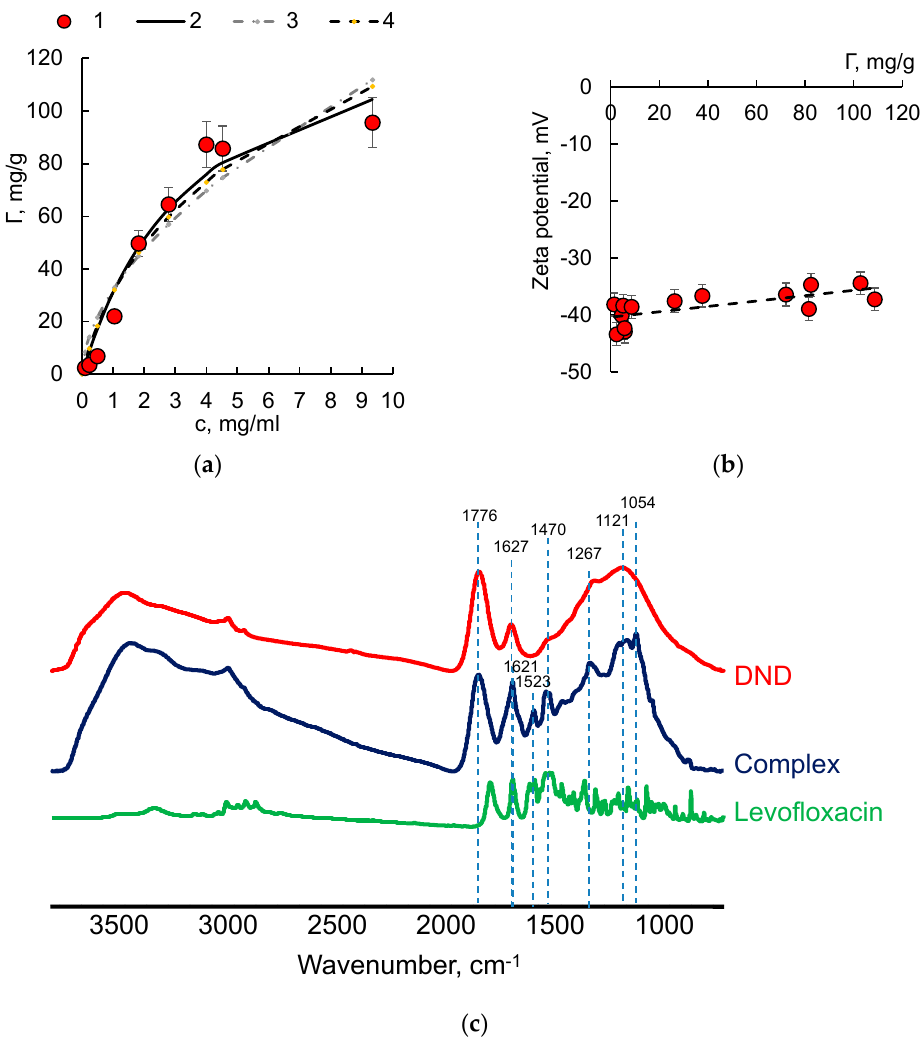
Figure 3. Characteristics of DND–levofloxacin complex. ( a ) The dependence of levofloxacin surface concentration on its equilibrium concentration in the aqueous phase (1) experimental data, (2) fitting with Langmuir equation, (3) fitting with Freundlich equation, (4) fitting with Dubinin–Radushkevich equation. ( b ) The dependence of zeta potential of DND–levofloxacin species in the aqueous suspension on levofloxacin surface concentration. ( c ) FTIR spectra of DND, DND–levofloxacin complex and levofloxacin.